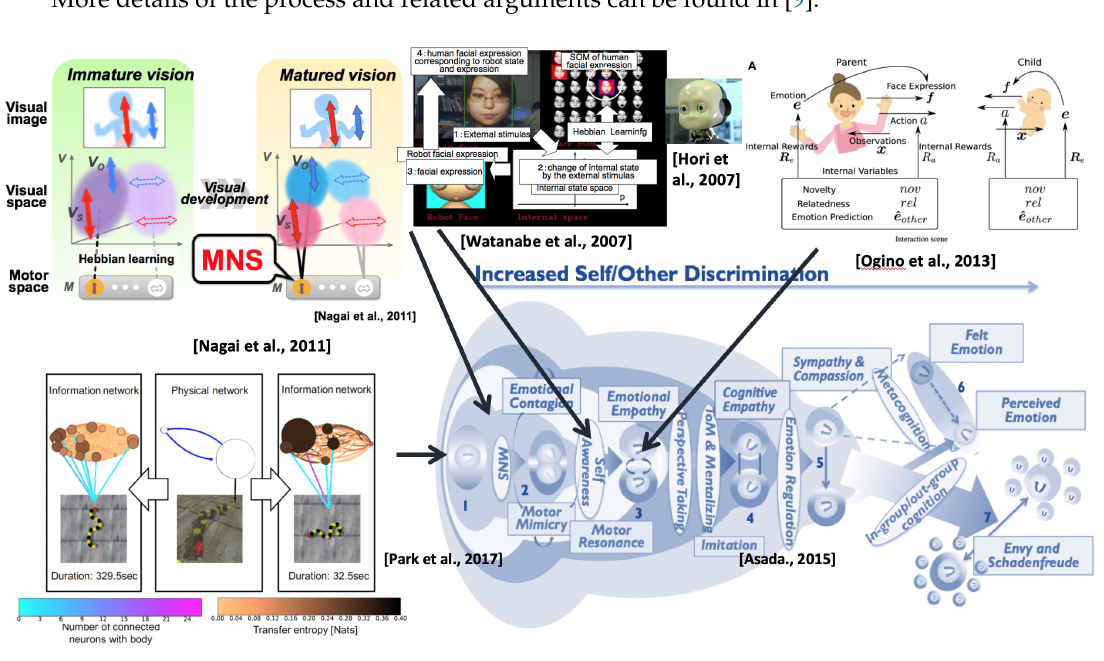
Figure 8. A conceptual model of empathy development and related